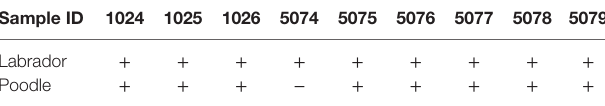
TaBle 1 | Indication ( + = correct; − = false) of dog at first contact with breath sample of patient suffering from lung